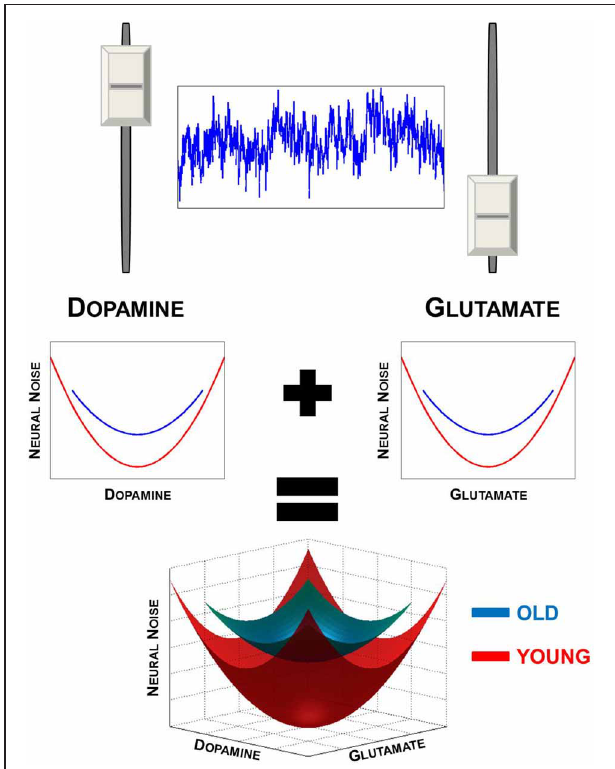
FIGURE 1 | Degeneracy in neural noise modulation. Upper panel illustrates that both GLU and DA have an effect on neural noise levels. Noise is highest when both DA and GLU levels are either too high or too low. Lower panel provides an illustration of the U-shaped the relationship DA and GLU have with neural noise (upper panels). When these two functions are combined, a 3-dimensional solution surface or manifold is formed (lower panel), illustrating the degeneracy in neural noise modulation. Also illustrated is the effect of aging, which results in the narrowing of the range of DA and GLU levels in the elderly. This results in a smaller solution manifold, restricting the range of neural noise levels in the